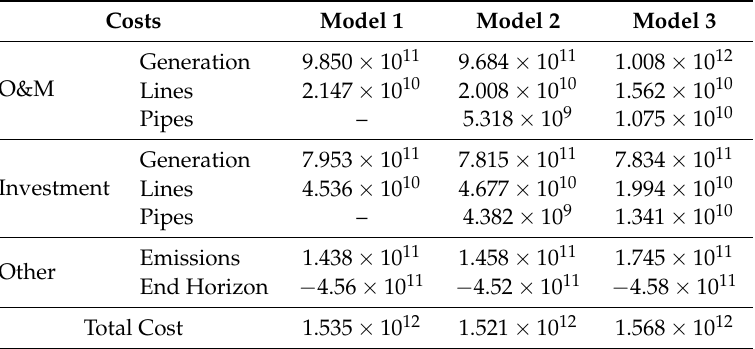
Table 5. Cost comparison (dollars).